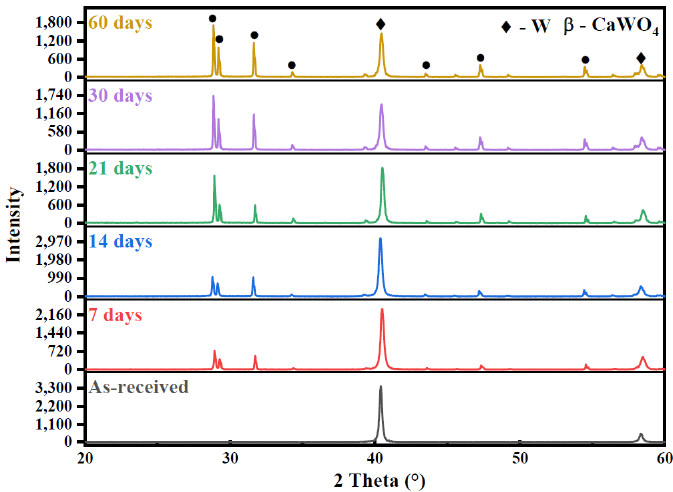
Figure 3. XRD patterns of as-received tungsten and corrosive tungsten in tap water for 7, 14, 21, 30 and 60 days. ◆ and • are the signs representing a peak belong to tungsten (W) and CaWO 4 , respectively.